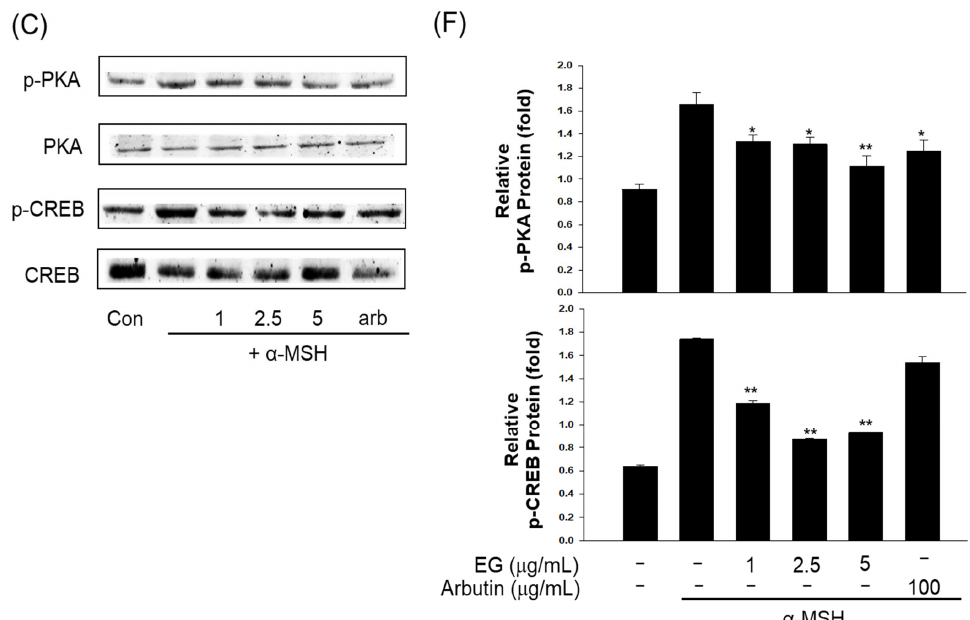
Figure 10. ( A ) Effect of ethyl gallate (EG) and arbutin on tyrosinase (TYR), tyrosinase-related protein 1 (TRP-1), and tyrosinase-related protein 2 (TRP-2) protein expression in B16F10 melanoma cells. The cells were treated with the indicated concentrations of EG and arbutin prior to α -melanocyte- stimulating hormone ( α -MSH) treatment for 24 h. The loading control was assessed using a β -actin antibody. ( B ) Effect of EG and arbutin on microphthalmia-associated transcription factor (MITF) protein expression in B16F10 melanoma cells. The cells were treated with the indicated concentrations of EG and arbutin prior to α -MSH treatment for 4 h. ( C ) Effects of EG and arbutin on phosphorylated protein kinase A (p-PKA), PKA, phosphorylated cAMP response element binding (p-CREB), and CREB protein expression in B16F10 melanoma cells. The cells were treated with the indicated concentrations of EG and arbutin prior to α -MSH treatment for 3 h. ( D ) Quantitative analysis of TYR, TRP-1, and TRP-2 by Western blotting. ( E ) Quantitative analysis of MITF by Western blotting. ( F ) Quantitative analysis of p-PKA, PKA, p-CREB, and CREB by Western blotting. * p < 0.05, ** p < 0.01, compared with α -MSH treatment.